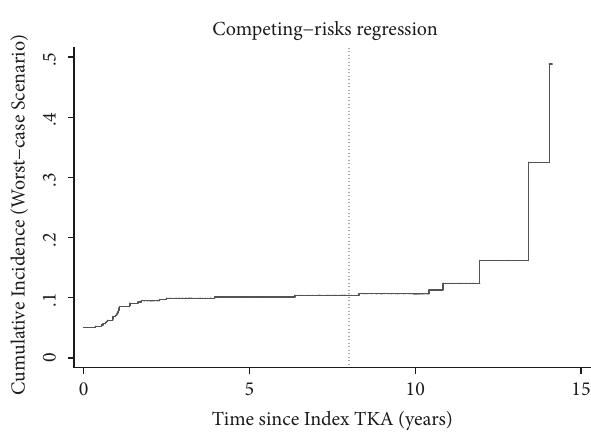
Figure 4: The cumulative incidence curve for the worst-case scenario with failure defined as revision of any component or lost to follow-up.